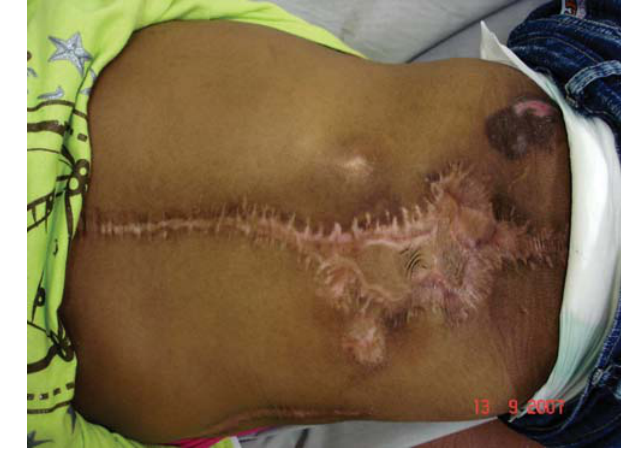
Figure 10 - The latissimus dorsi was skin grafted two weeks later. Final aspect of the healed